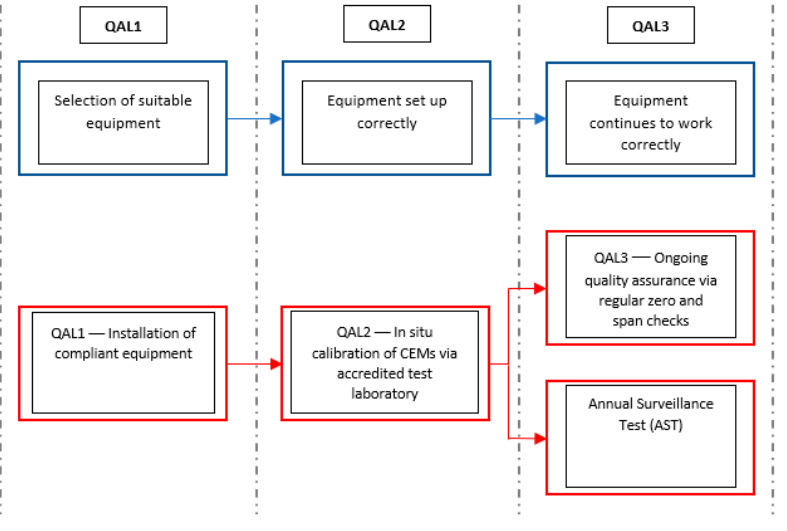
Figure 1. Operator equipment requirements.